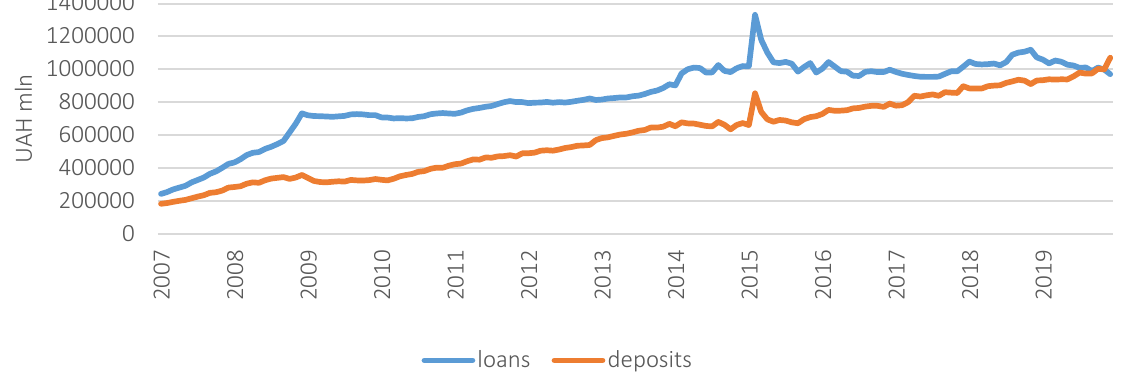
Figure 3. Dynamics of loans and deposits in the Ukrainian banking